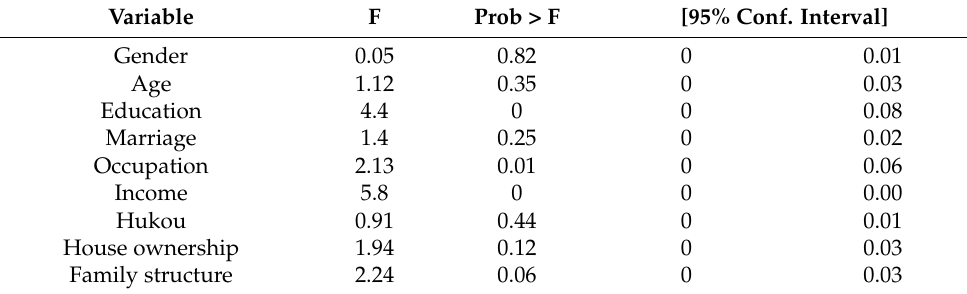
Table A5. Result of one-way ANOVA analysis.